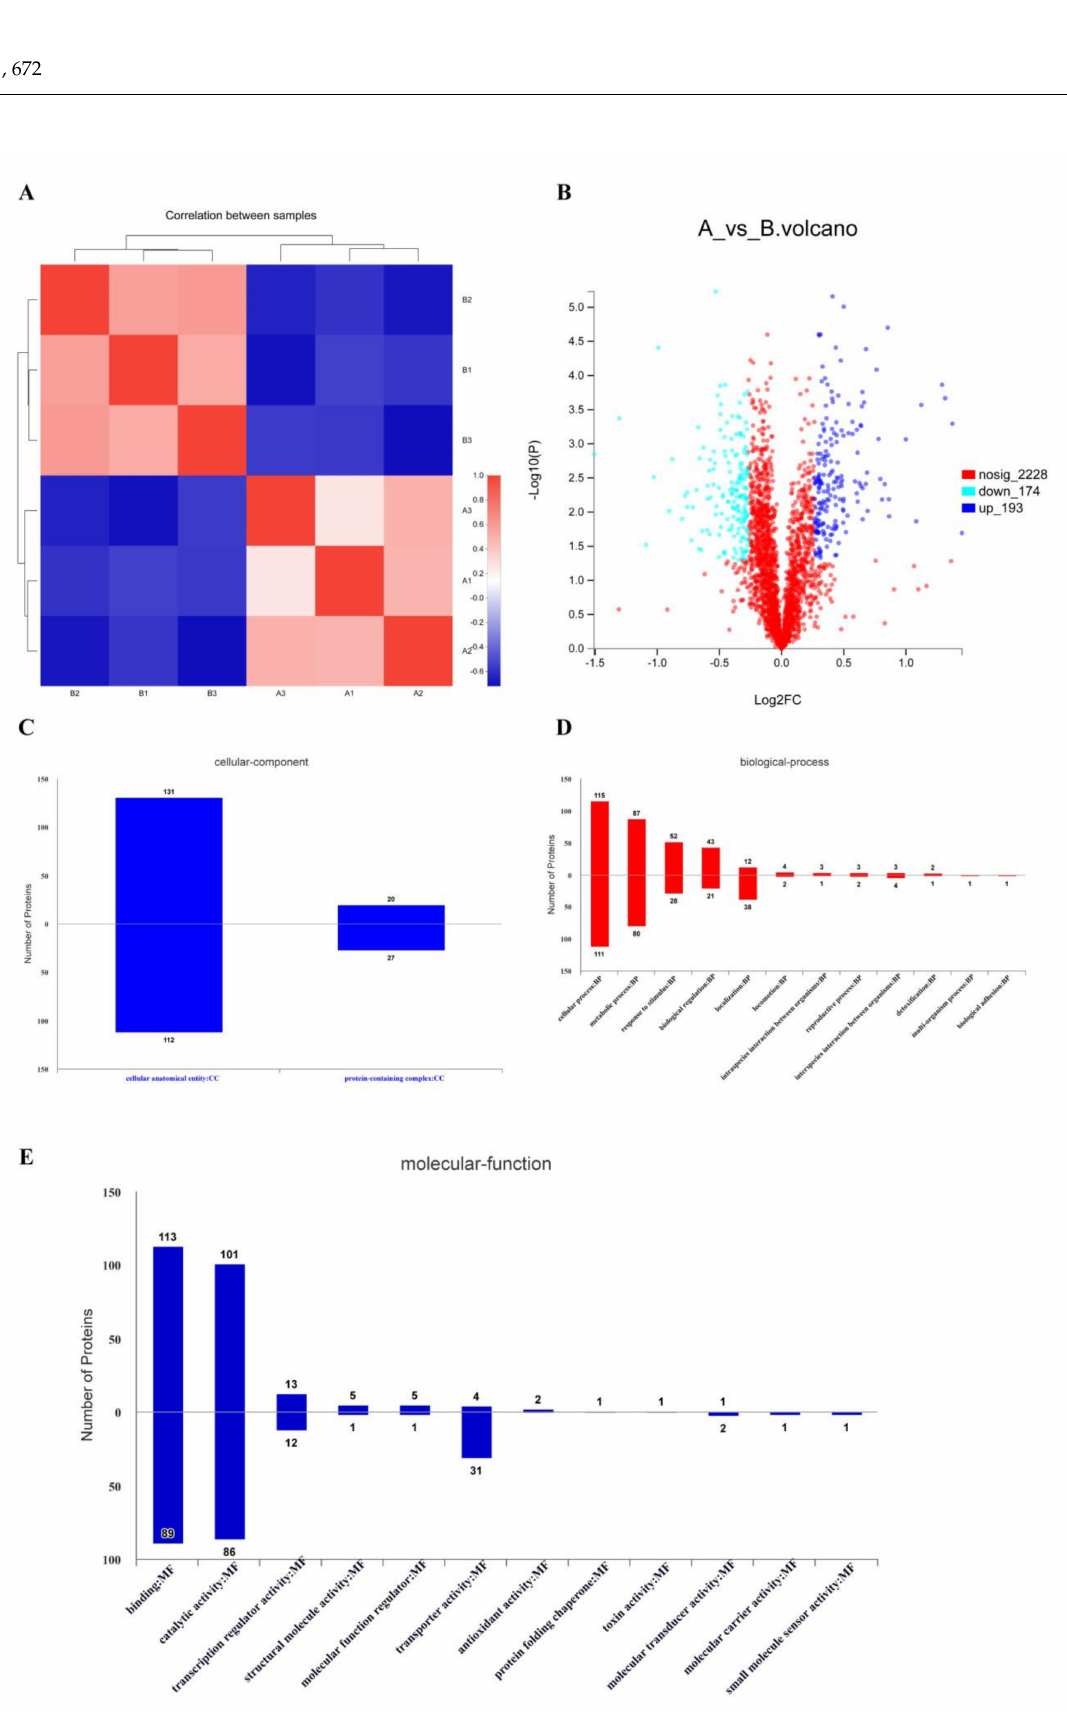
Figure 3. ITRAQ proteome profiling was identified in E. coli treated with BCp12. ( A ) Heat map of proteins from E. coli ; treatments: A1, A2, and A3; control: B1, B2, and B3. ( B ) The volcano map of the differentially expressed proteins in E. coli . ( C ) Cellular component of GO analysis. ( D ) Molecular function of GO analysis ( E ) Biological process of GO